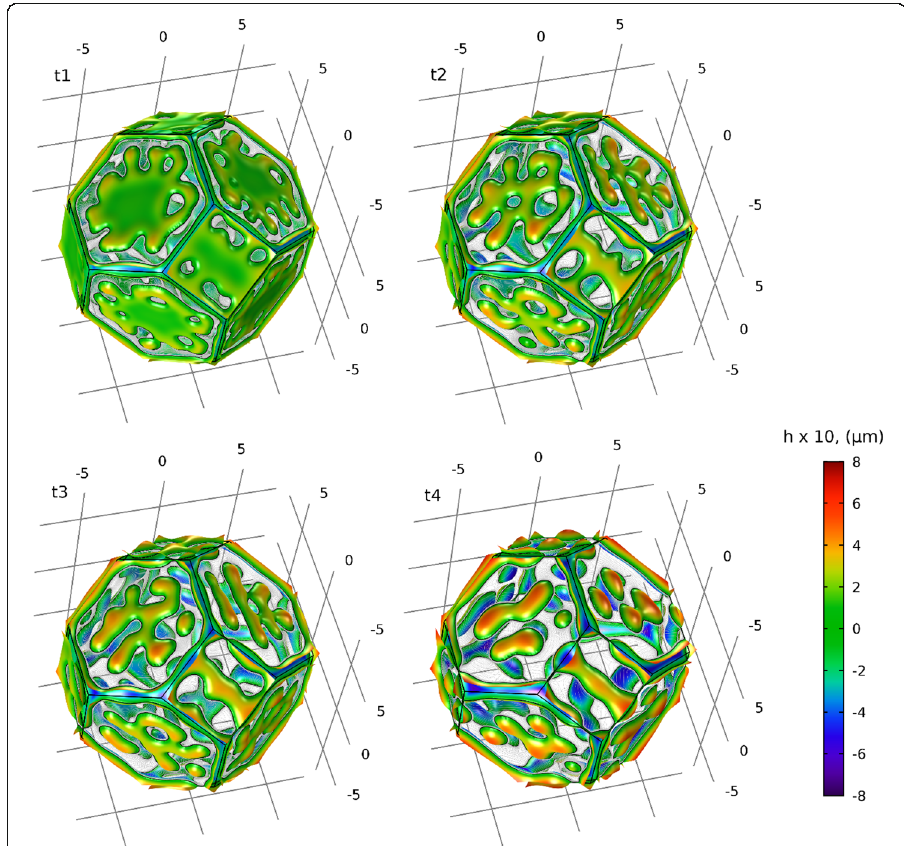
Fig. 14 Results of grain boundary porosity simulation progressing from top left to bottom right showing decomposition of the initial fluctuating porosity into discrete bubbles followed by interlinkage, coalescence, and relocation towards edges Additional file